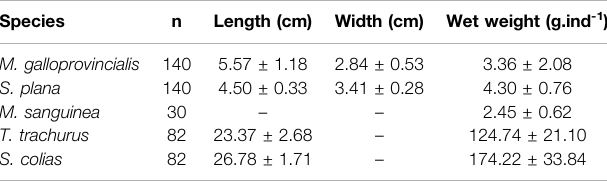
TABLE 1 | Biometric parameters of the studied species (average ± standard deviation (SD), n — number of individuals). Species